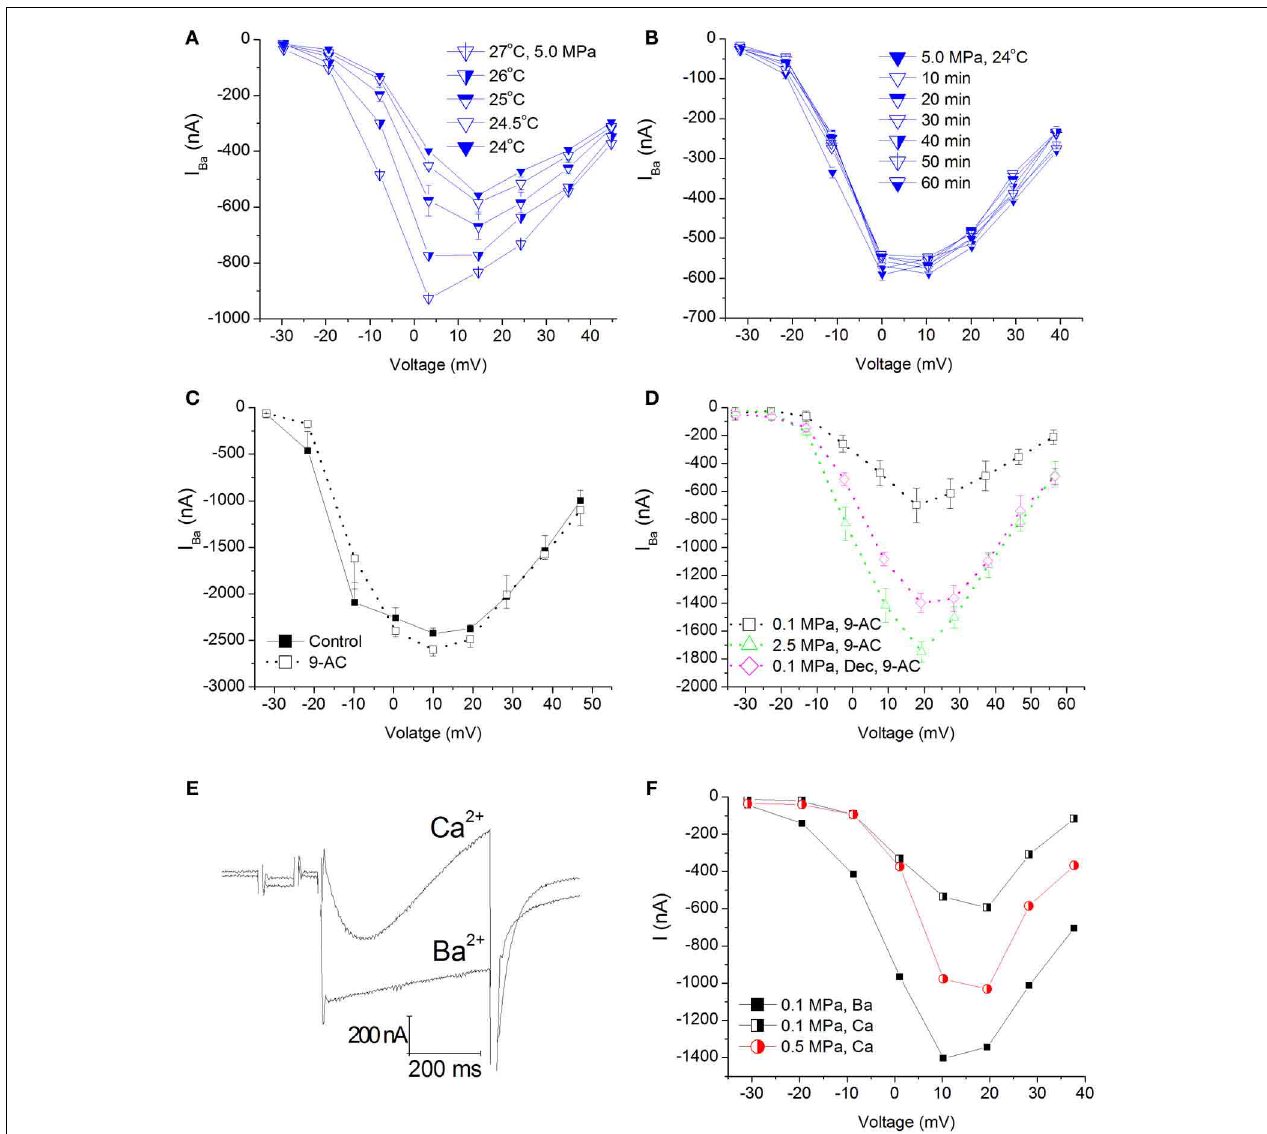
FIGURE 3 | Temperature, time, Cl − channel blocker, and Ca 2 + ion (augmentation) is evident. (E) Example of current traces recorded with Ca control experiments in Ca V 1.2 channel. (A) I–V curves measured at Ca 2 + or Ba 2 + ions in the solution at the same depolarization to 0mV. 5.0MPa repeatedly while the preparation’s adiabatic temperature change Note the stronger and faster inactivation with Ca 2 + . (F) Compression to 0.5MPa when Ba 2 + ions were replaced by Ca 2 + ions. Replacement of is subsiding. (B) I-V curves measured in a different oocyte for 1h at ions caused a decrease of the currents at 0.1MPa, but compression to 5.0MPa after control temperature was regained. (C) I-V curves 0.5MPa still augmented the Ca 2 + current in a similar manner to Ba 2 + measured in a solution containing 9-AC. (D) I-V curves of compression and decompression performed with 9-AC. The expected HP effect